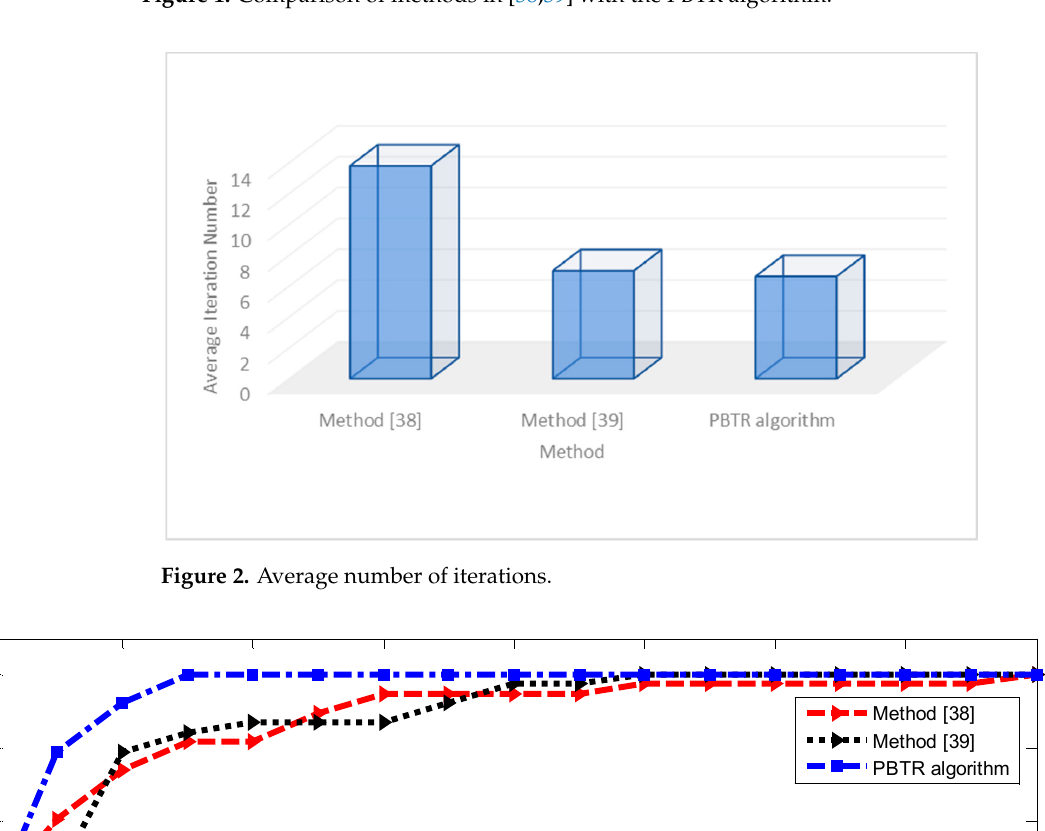
Mathematics 2021 , 9 , x Figure 1. Comparison of methods in [38,39] with the PBTR algorithm. Figure 1. Comparison of methods in [38,39] with the PBTR algorithm.